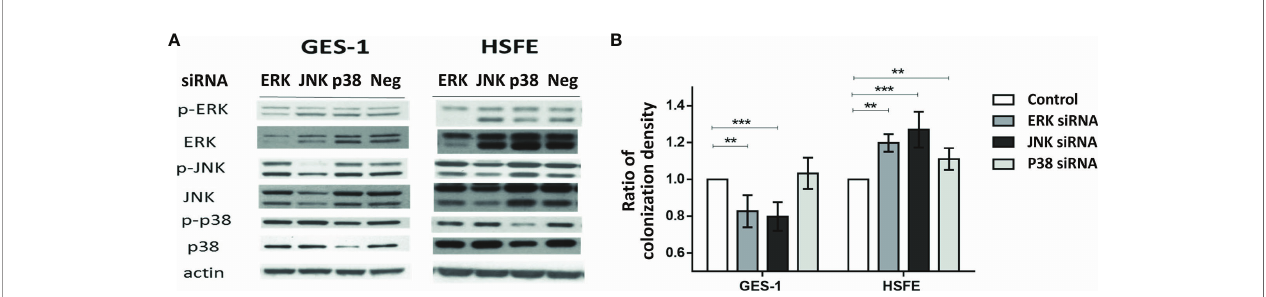
FIGURE 5 | The impact of MAPK activation after H. pylori challenge on the colonization intensity between GES-1 and HSFE cells. GES-1 and HSFE cells were transfected with ERK, JNK, p38, and negative control (Neg) siRNA 10 r g with 8 m l RNAi MAX Lipofectamine. The cells were then challenged with H. pylori (MOI 100) for 1 hour. (A) SiRNA transfection ef fi ciency was con fi rmed by Western blot. (B) The intensity of H. pylori colonization was detected by fl ow cytometry using speci fi c antibodies. Each test was in triplicate. Data are expressed as means ± SD. Statistical analysis was performed for each measurement with comparisons to the negative control. ** P < 0.01, *** P < 0.001).